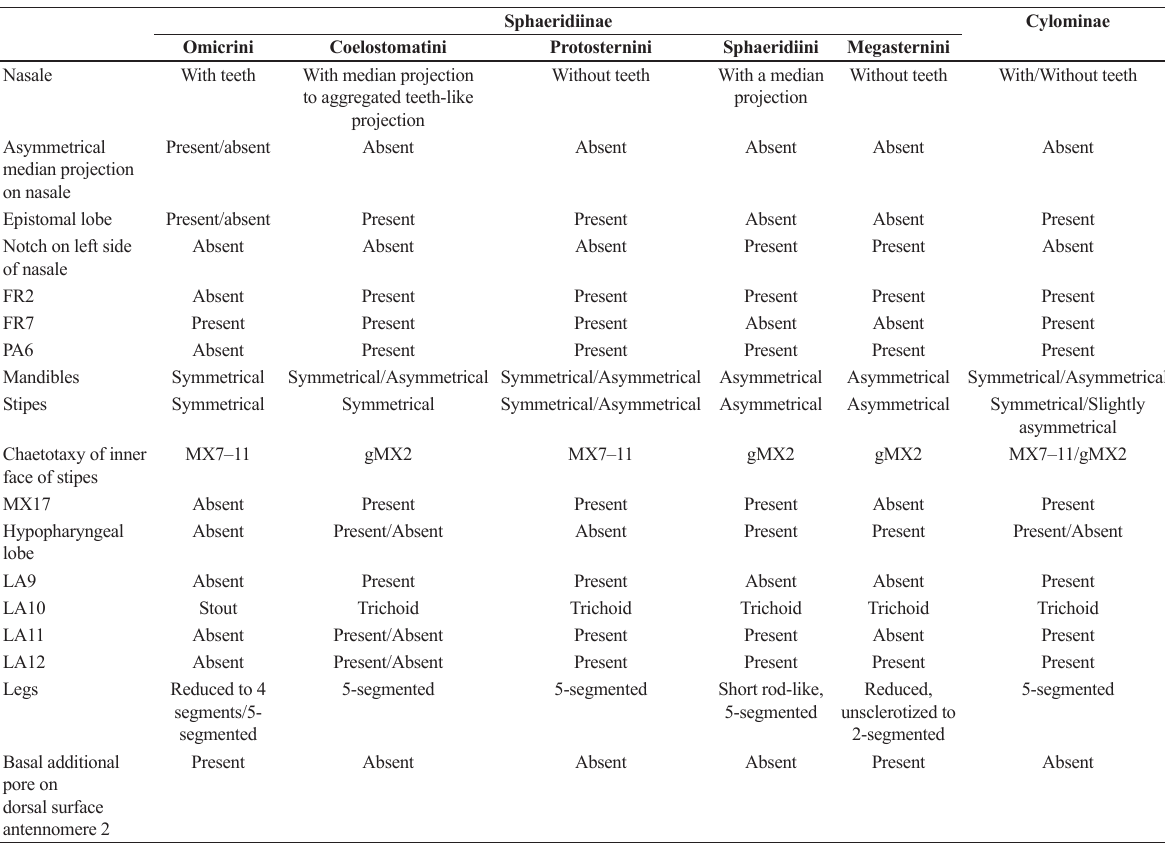
Table 3. Morphological characters of Sphaeridiinae and Cylominae